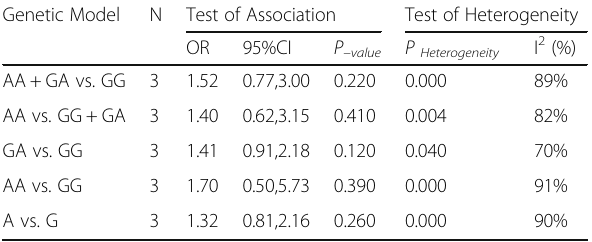
Table 5 Summary of odds ratios (95% CI) in the analysis of the relationship between VEGF gene polymorphisms in rs1570360 and coronary artery disease susceptibility